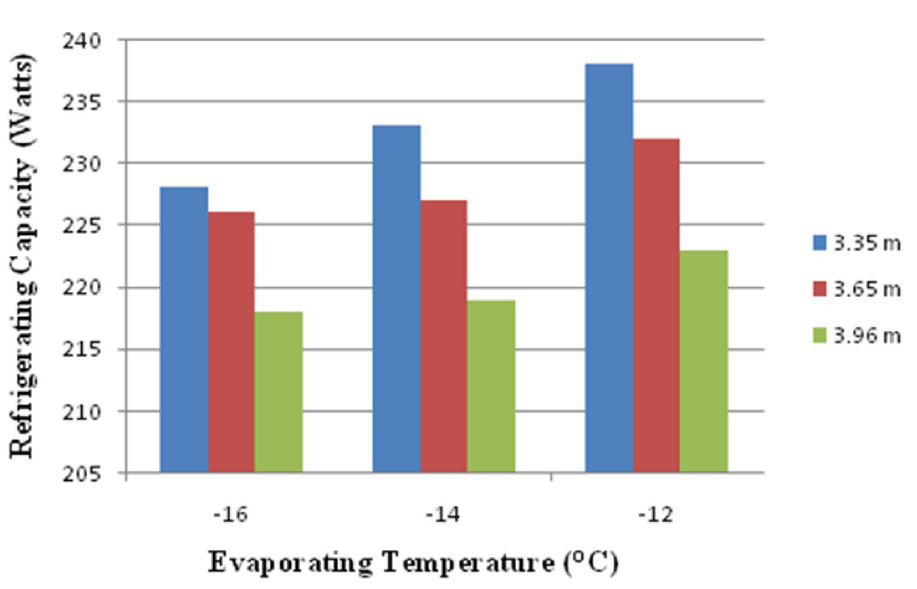
Figure 11. Variation of refrigerating capacity against capillary length and evaporating